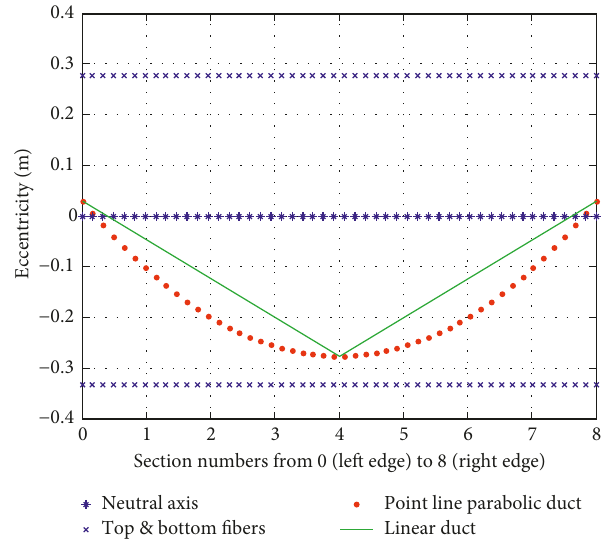
Figure 5: Position of the tendon, neutral axis, and top and bottom fibres across the